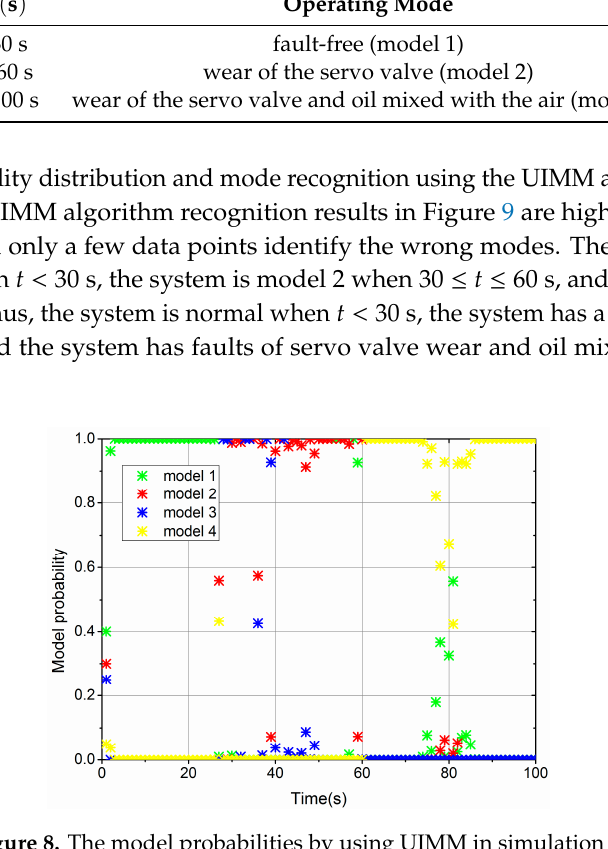
Figure 9. The mode recognition results in simulation 2. 5. Conclusions To address the issue of multiple faults occurring in HA of a flight control system, this study designed a multi-fault diagnosis method for the HA based on UIMM. In this strategy, after analyzing the typical failure modes and failure mechanisms of HA, the key physical parameters of the system are obtained and models that can reflect different typical single fault of the system are established. This allows tracking of the real state of the system in real time by matching the model with the system state. System failure is not reversible without troubleshooting. If a new fault occurs, all corresponding parameters in the fault models are replaced by fault values. In the case of multiple faults, this approach can greatly reduce the number of system fault models. Compared with traditional IMM, UIMM can diagnosis multiple faults with fewer models to avoid combination explosions. The simulation results indicate the effectiveness of the novel method. Nevertheless, coupling faults are not considered here, which should be addressed in the future. Author Contributions: X.S. and X.W. designed the fault diagnosis strategy. X.S. and S.L. performed the simulations. X.S. and S.L. wrote the paper. All authors have read and agreed to the published version of the manuscript. Funding: This research was funded by the Open Fund of Key Laboratory of Civil Aircraft Airworthiness Technology (SH20190709-2) and the National Natural Science Foundation of China (Grants No. 51675019). Conflicts of Interest: The authors declare no conflict of interest.